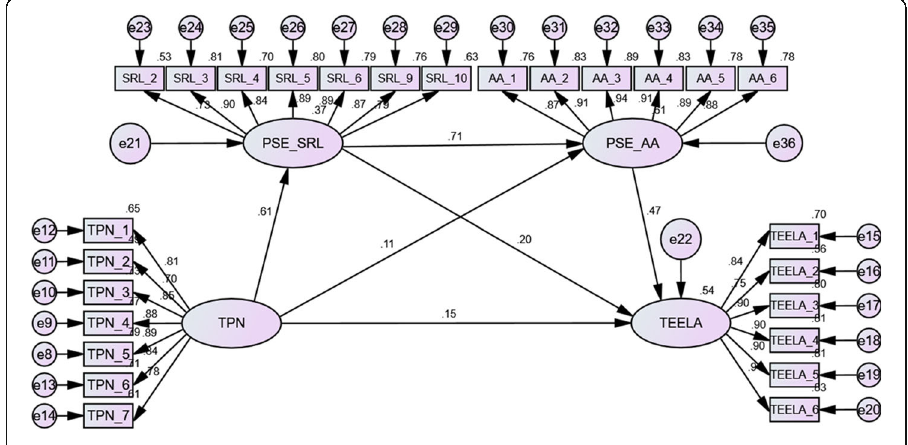
Fig. 4 Structural Equation Modeling of the Hypothesized Model with Standardized Coefficients and